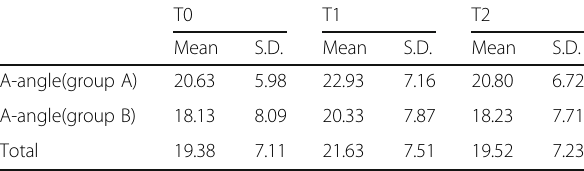
Table 1 Average position of the condyle on the axial